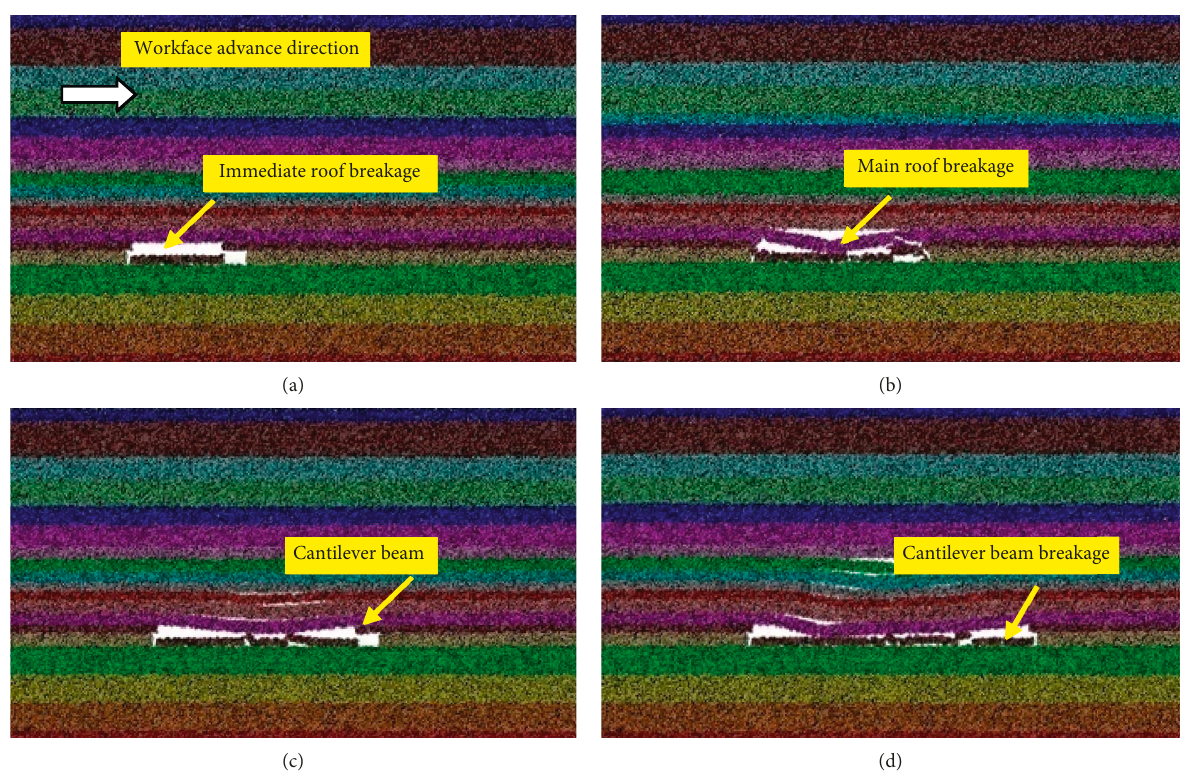
Figure 11: The roof activity law of different workface advance distances: (a) 30m; (b) 50m; (c) 80 m; (d)